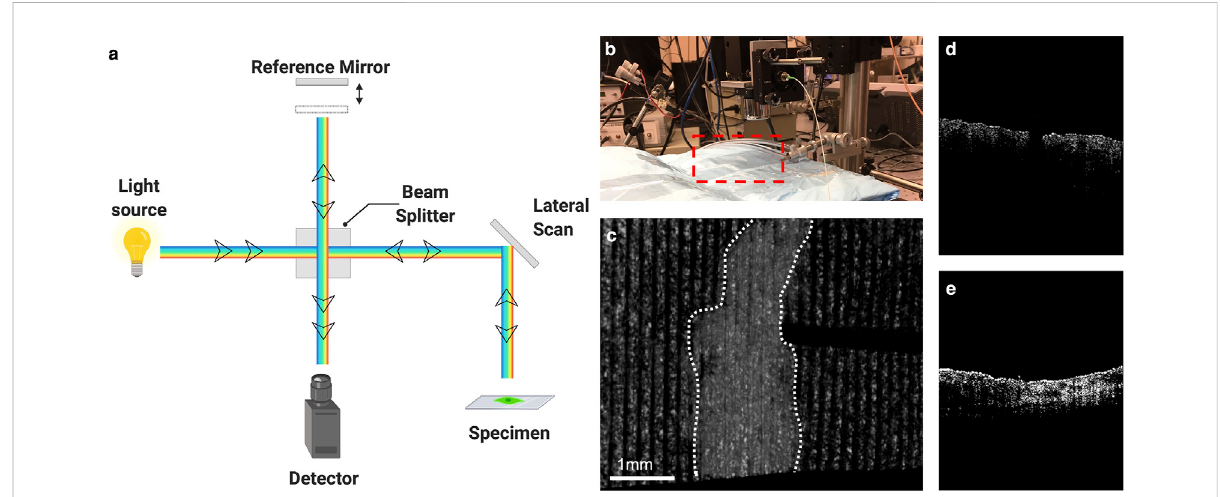
FIGURE 3 Optical coherence tomography and elastography. (A) Schematic of optical coherence tomography. (B) Set up for Optical Coherence Elastography. Red box designates location ofsample/subject of interest. (C) Elastographic map of mouse skin with scar denotedwithin white dotted lines. (D) Cross section of normal skin using OCE. (E) Cross section of scar using OCE. Illustration generated using Biorender.com. OCE images courtesy of Dr. Kirill Larin Lab at the University of